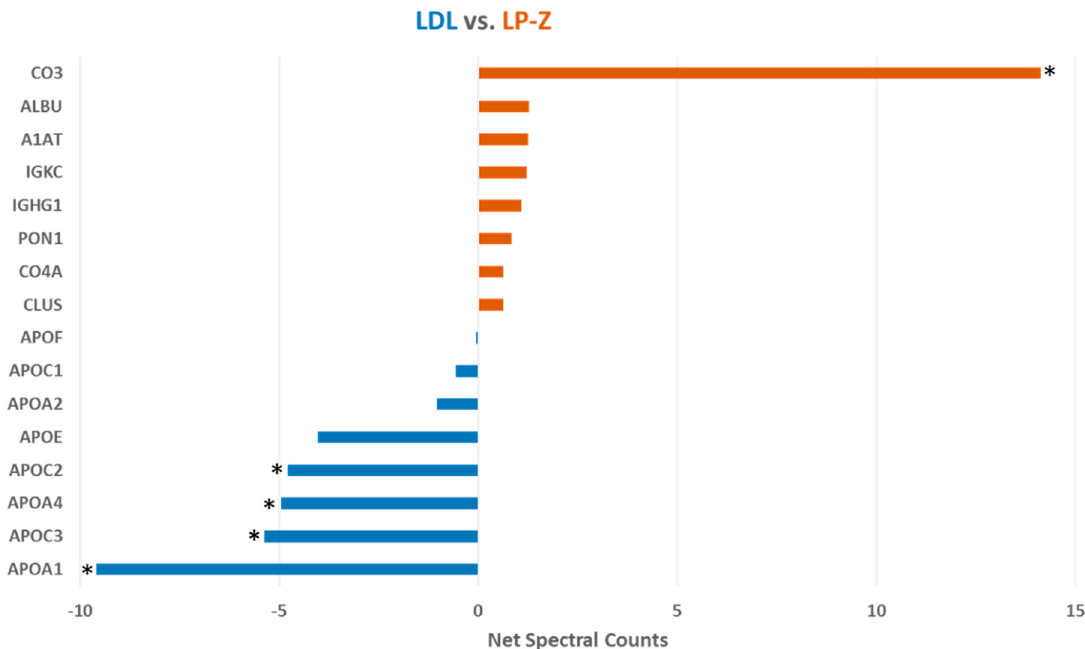
Figure 6. Proteomic composition of isolated LP-Z and LDL particles. * P value < 0.05 determined by t -test using Skyline Mass Spectrometry 1 (MS1) data normalized to apoB peptides. LDL particle data are in blue ( n = 6) and LP-Z particle data are in red ( n = 4). Abbreviations: LDL, low-density lipoproteins; CO3, complement C3; ALBU, albumin; A1AT, alpha1-antitrypsin; IGKC,